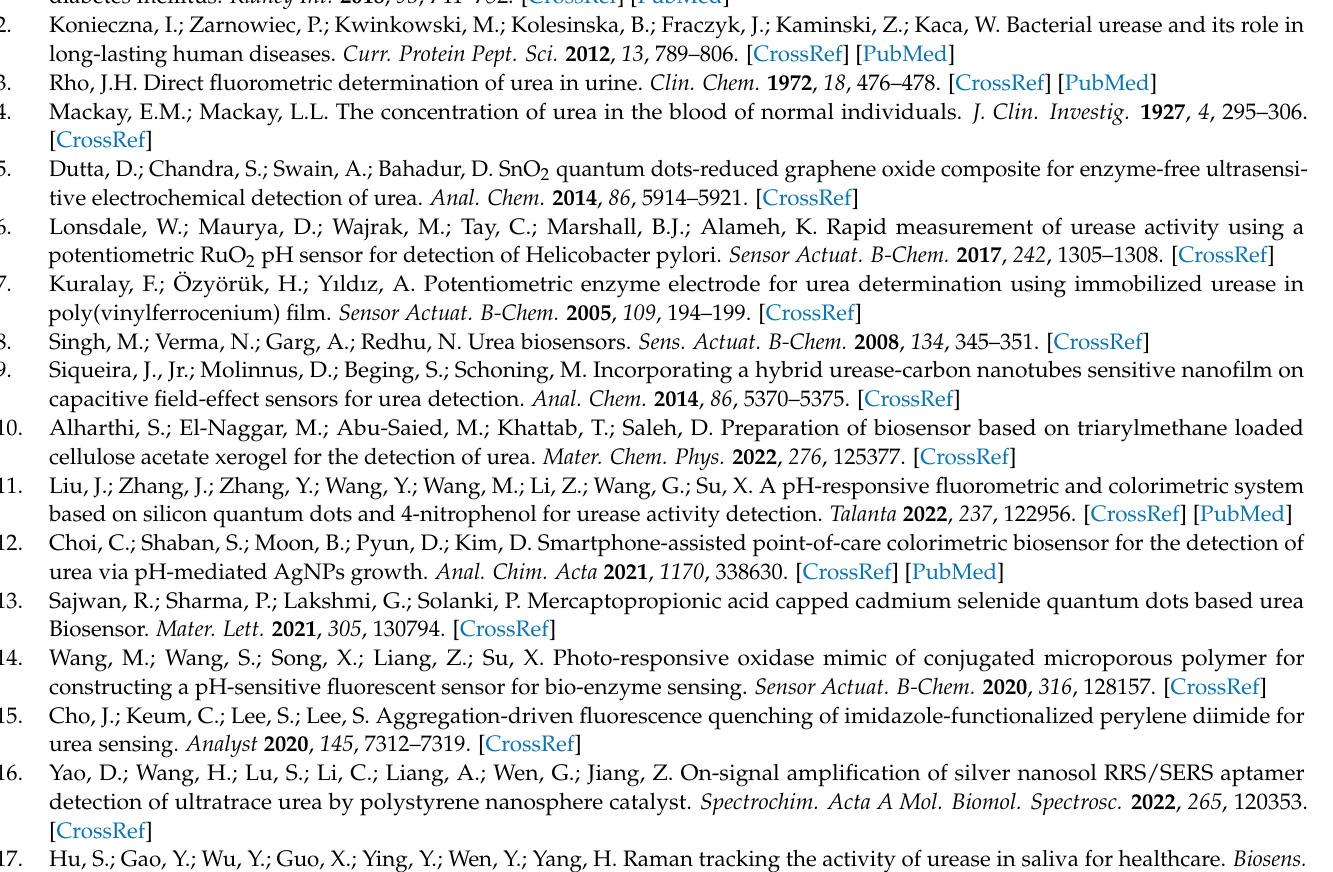
Figure S2: Zeta potential of Au NWs in water, Figure S3: The lifetime of Au NWs, Figure S4: Stability of Au NWs under irradiation, Figure S5: The changes in fluorescence intensity of Au NWs for 1 month at 4 ◦ C and room temperature, Table S1: Absolute quantum yield of Au NWs in aqueous solution, Table S2: Comparison of the proposed method with reported urea-determination methods, and Table S3: Comparison of the proposed method with reported urease-detection